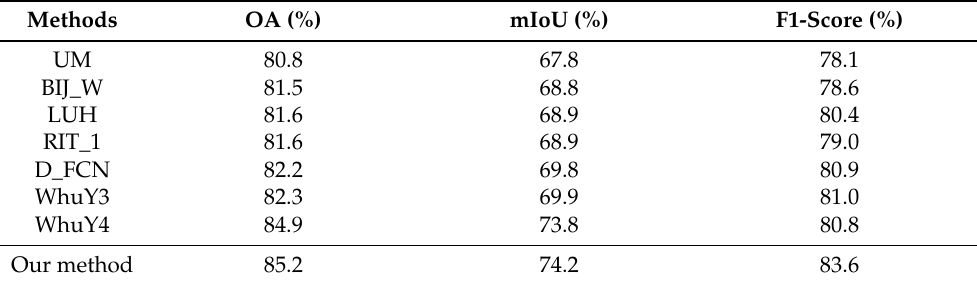
Figure 9. Misclassified regions in the Vaihingen site caused by unexpected connections between supervoxels of different objects. ( a – c ) mean misclassification situations in different minor scenes from roof to vegetation. Table 3. Quantitative comparison of the proposed method and previous related methods tested on the Vaihingen sites sorted by overall accuracy (OA) in ascending order. The F1-score was computed based on the same categories (building, vegetation, and